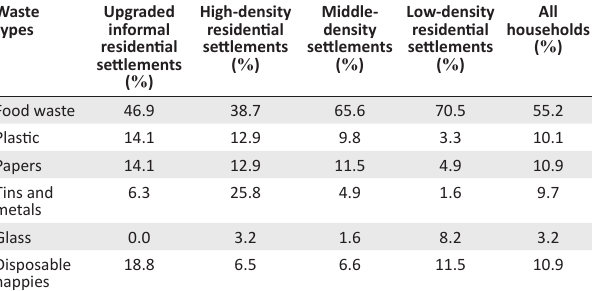
TABLE 3: The most common types of waste according to socio-economic status – Characteristics of generated waste. Waste